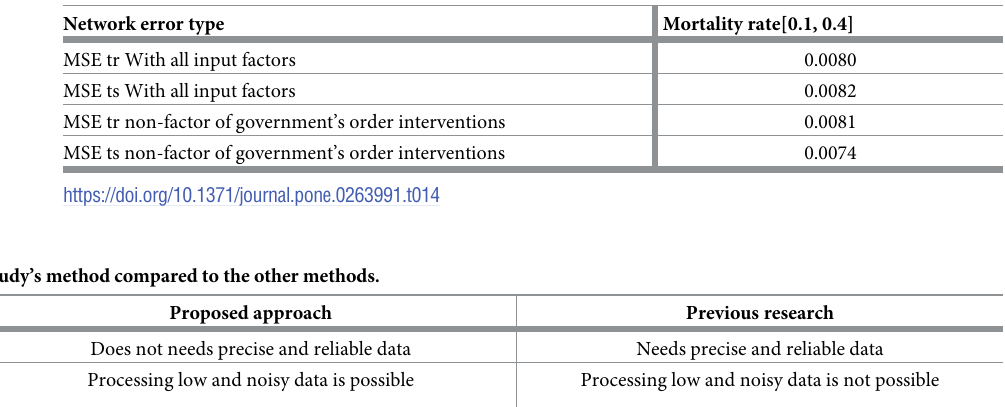
Table 14. The effect of non-factor of government’s order interventions on the total squared error of ANN-BTA network of the government with the mortality rate output of [0.1, 0.4].